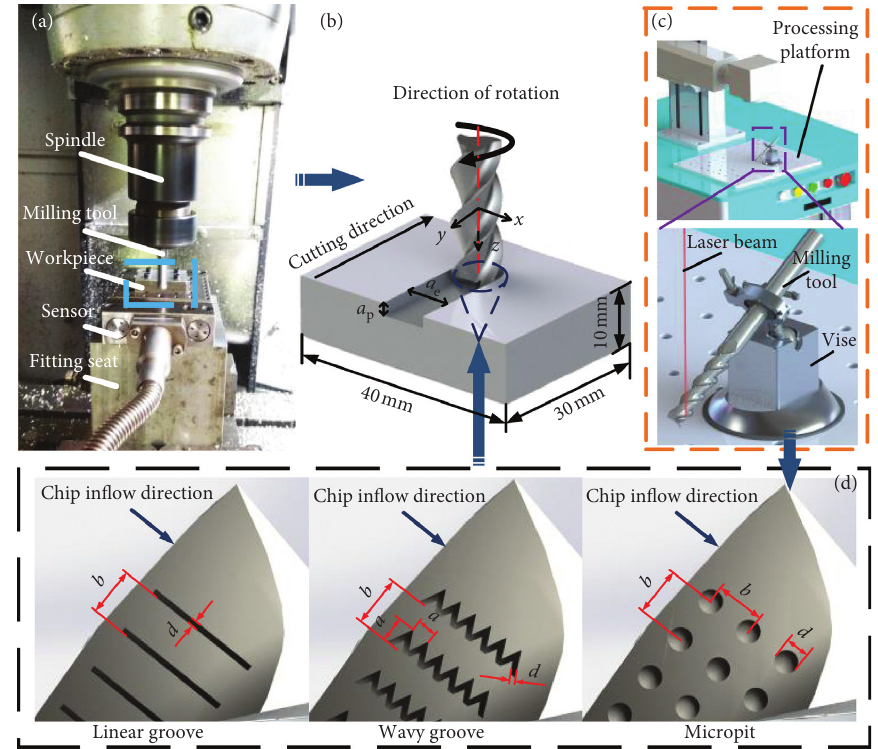
Figure 1: Milling test system of textured tools. (a) Milling experiment; (b) cutting diagram of the milling cutter; (c) the textures are prepared on the milling tools; (d) schematic diagram of textures at the tip. Table 1: Parameters of the experiment system. Parameters of the laser